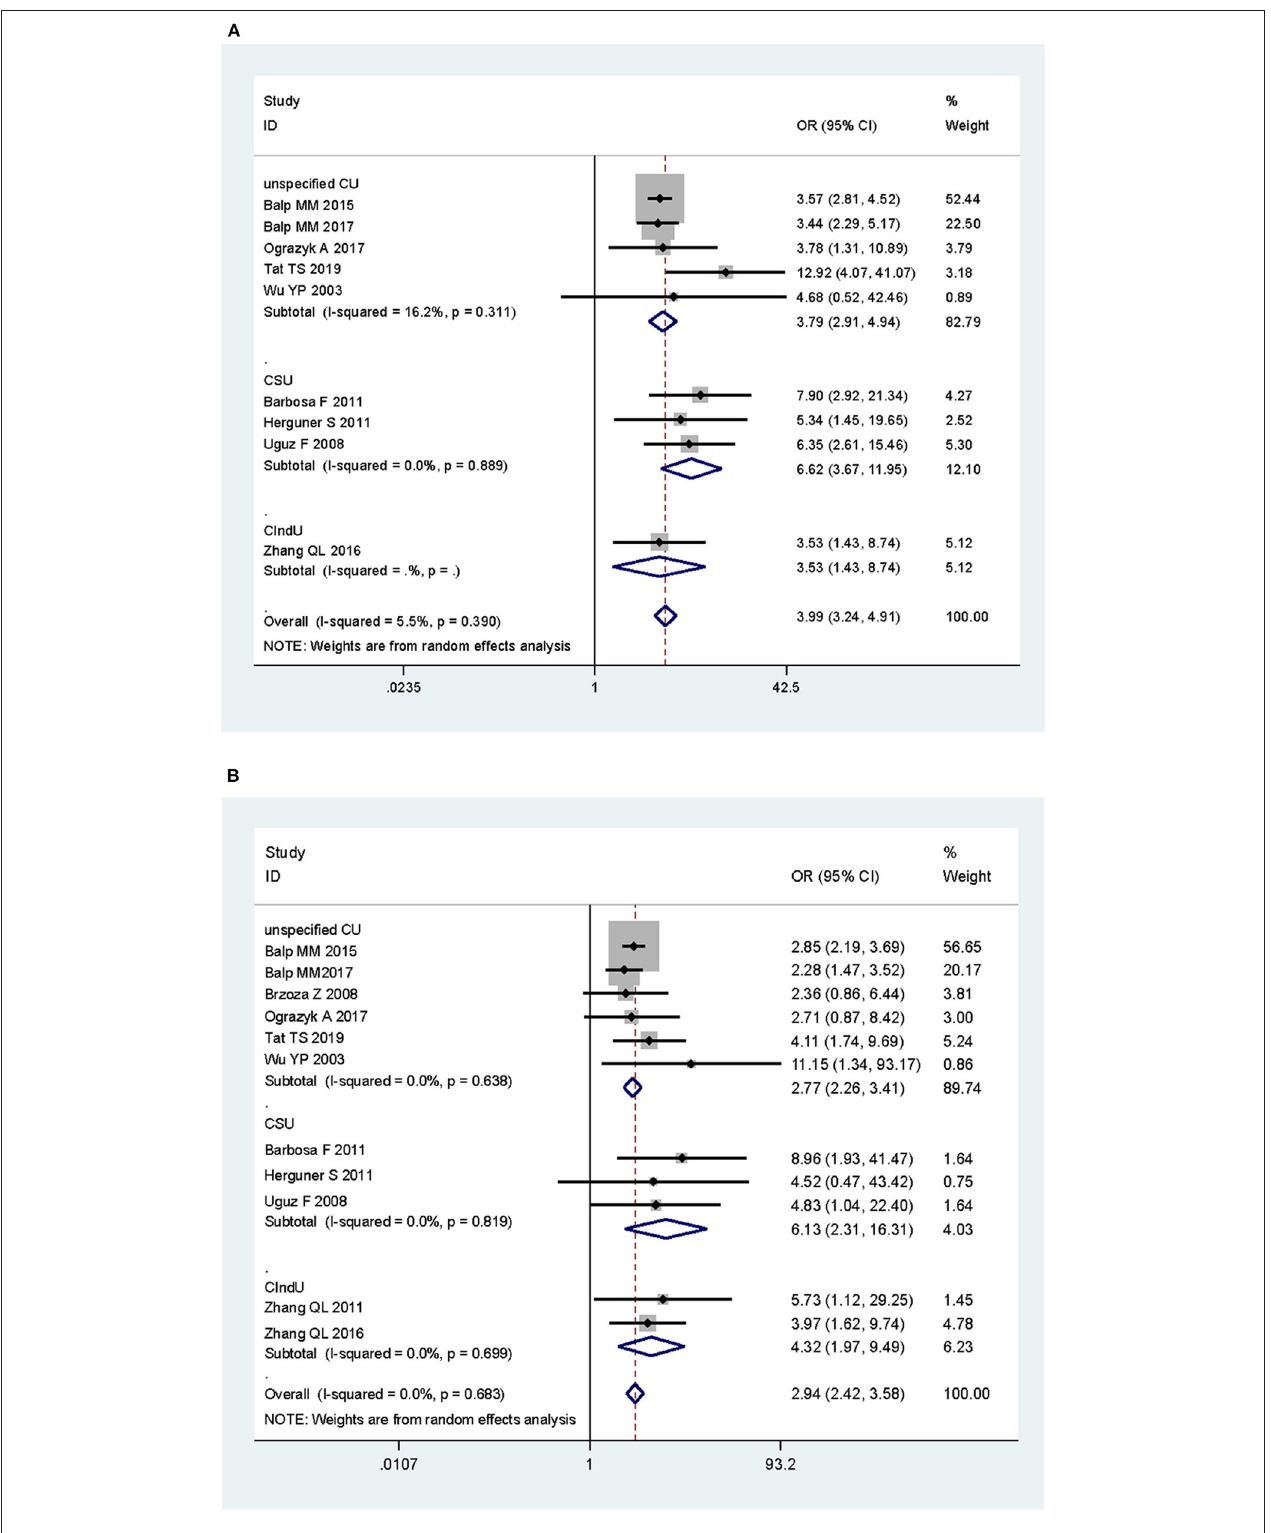
FIGURE 3 | Subgroup analysis of the associations of chronic urticaria with symptoms of anxiety and depression in terms of odds ratio, by subtypes of chronic urticaria. (A) Anxiety and subtypes of chronic urticaria. (B) Depression and subtypes of chronic urticaria. CU, chronic urticaria; CSU, chronic spontaneous urticaria; CIndU, chronic-induced